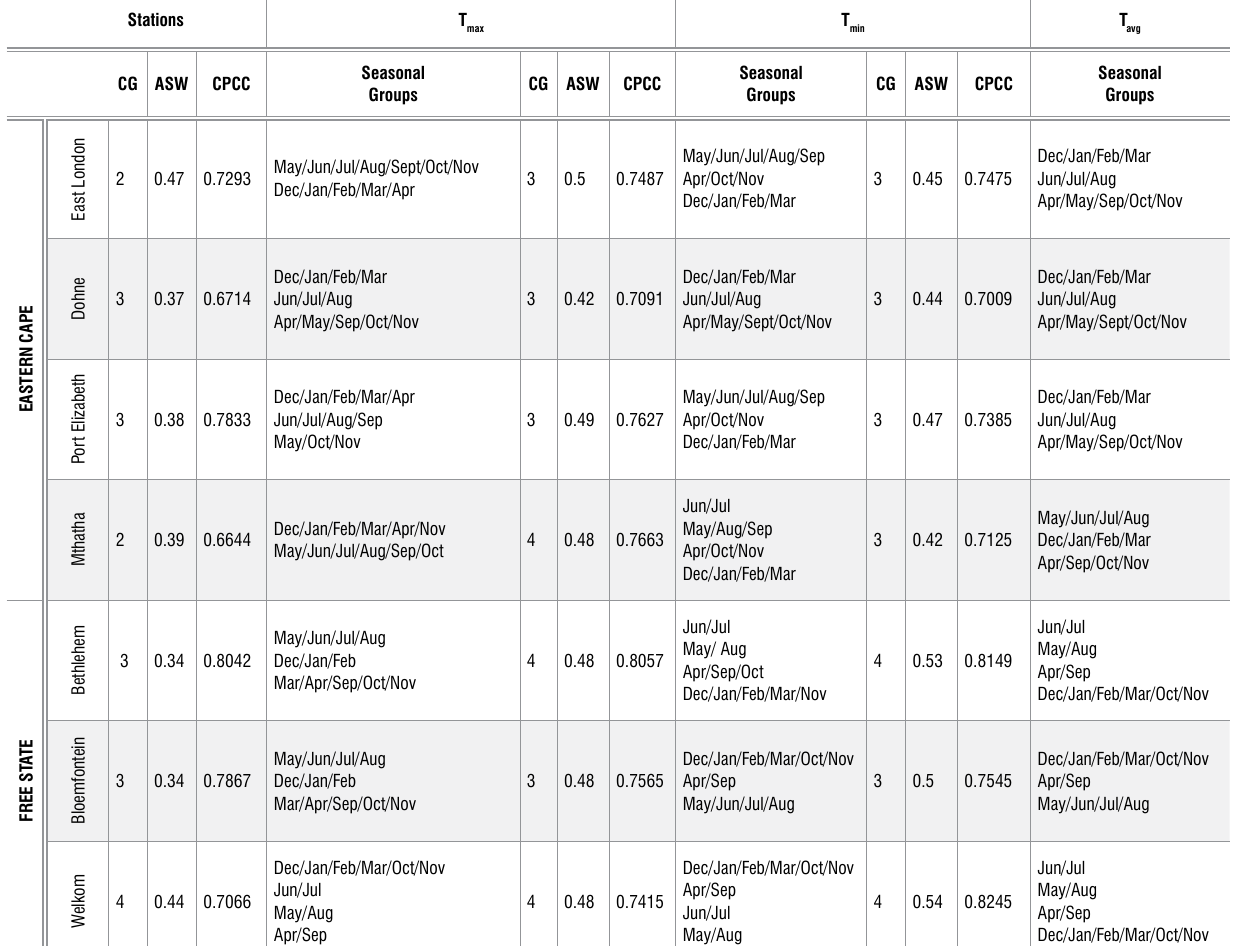
Output of the cluster analysis including cluster groups (CG), average silhouette widths (ASW) and cophenetic correlation coefficient (CPCC) scores Stations